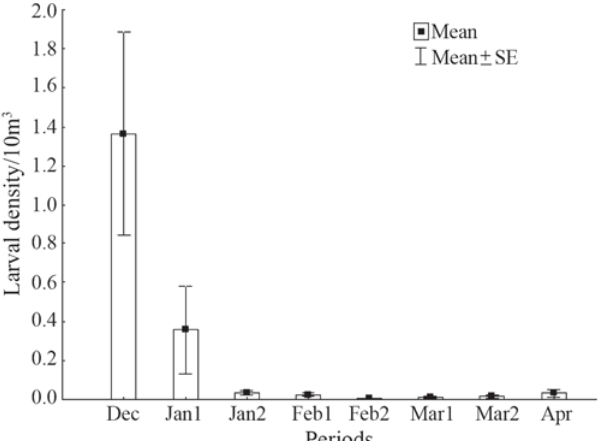
Fig. 5. Temporal distribution of the five taxonomic groups with the highest densities in marginal lagoons along the Cuiabá River between December 2006 and April